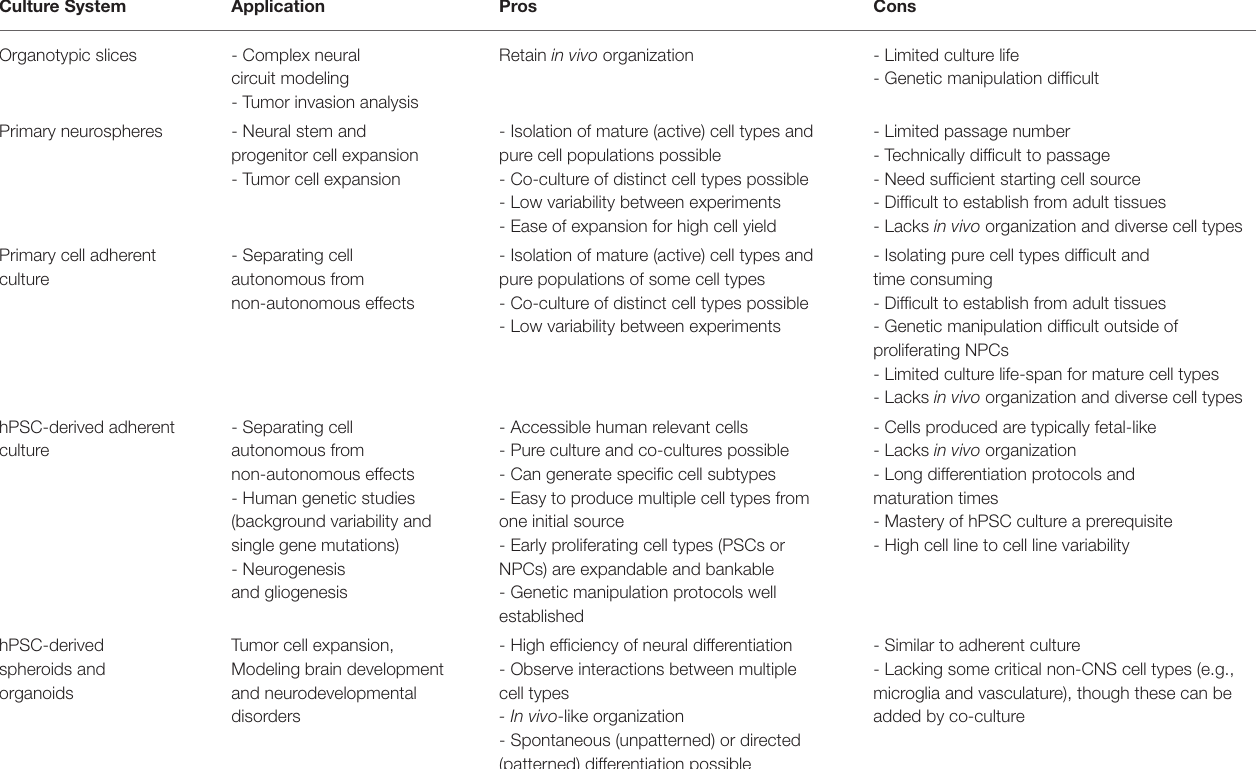
TABLE 1 | Comparison of typical neural culture systems. Culture